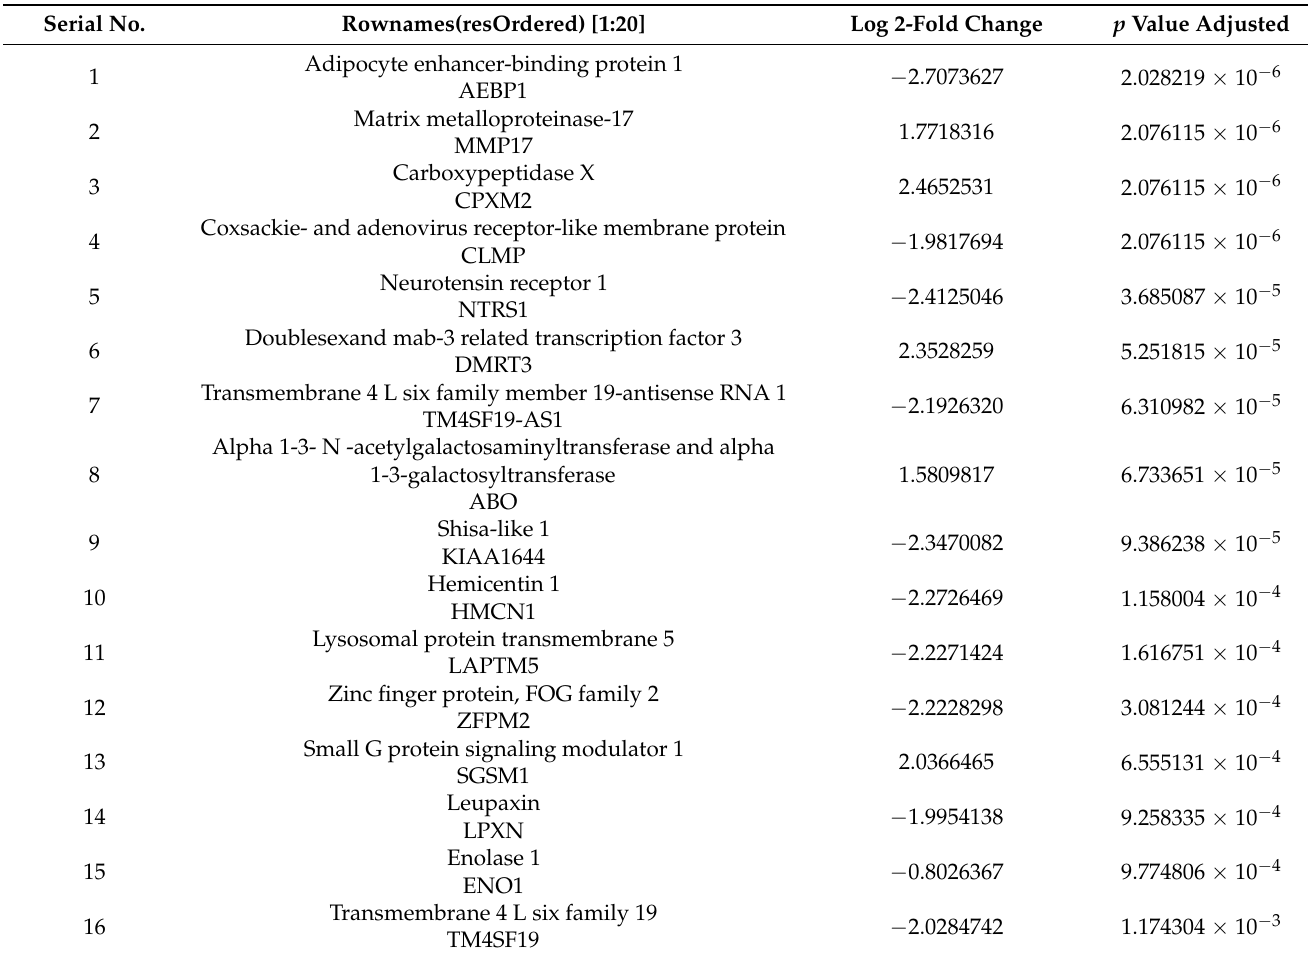
Figure 1. RNA-Seq results are clustered in this heatmap, showing differential expressions of AERD nasal polyp epithelial cells (NNPEC) versus AERD non-affected nasal area epithelial cells (NNAEC). In GEO, these two groups are annotated as affected vs not affected. Table 2. Differentially expressed genes with log 2-fold change.